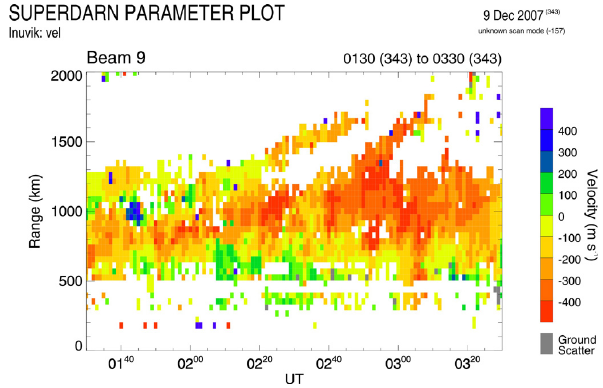
Fig. 5. Range-time-velocity plot for the Inuvik radar observations in beam 9 on 9 December 2007 between 01:30 and